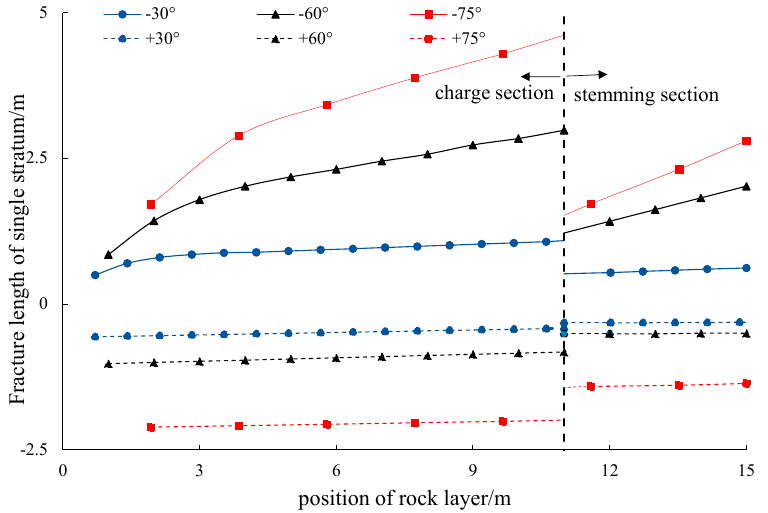
Figure 5. The law of maximum failure length of the rock cantilever beam structure under different conditions.